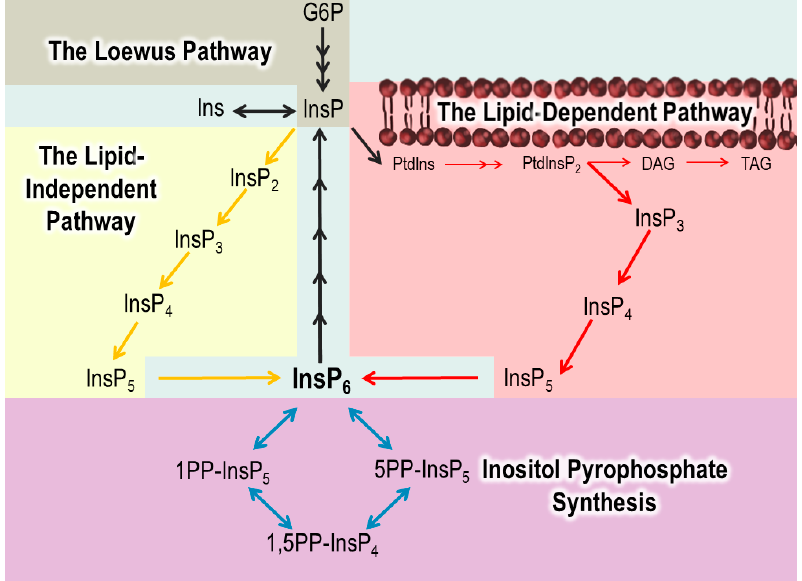
Figure 3. A simplified view of the InsP synthesis and degradation pathway. InsP synthesis starts in the Loewus Pathway (tan), where InsP is synthesized from Glucose-6-Phosphate (G6P). InsPs are synthesized through the Lipid-Dependent (pink) or Lipid-Independent (yellow) pathways. PP-InsPs in plants are synthesized from InsP 6 (purple). The enzymes involved in the pathway are discussed throughout the review.